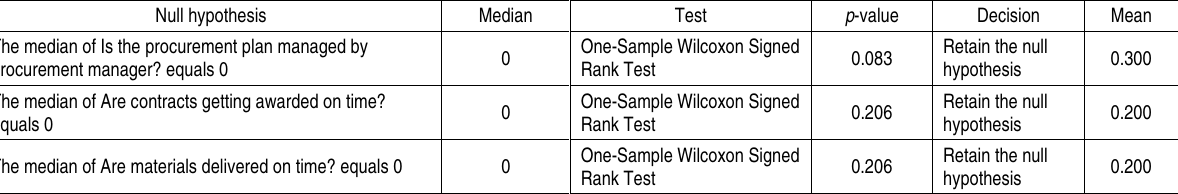
Table 3b. One-sample Wilcoxon signed rank